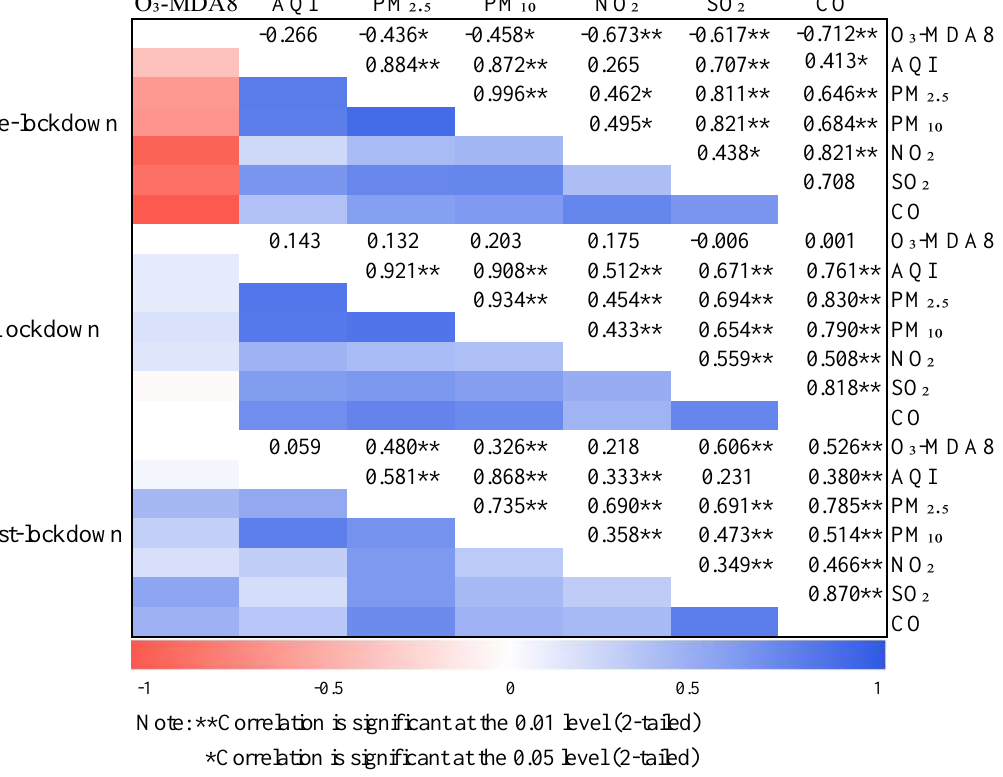
Figure 11. Correlation results between AQI and six basic pollutants in three preset periods.